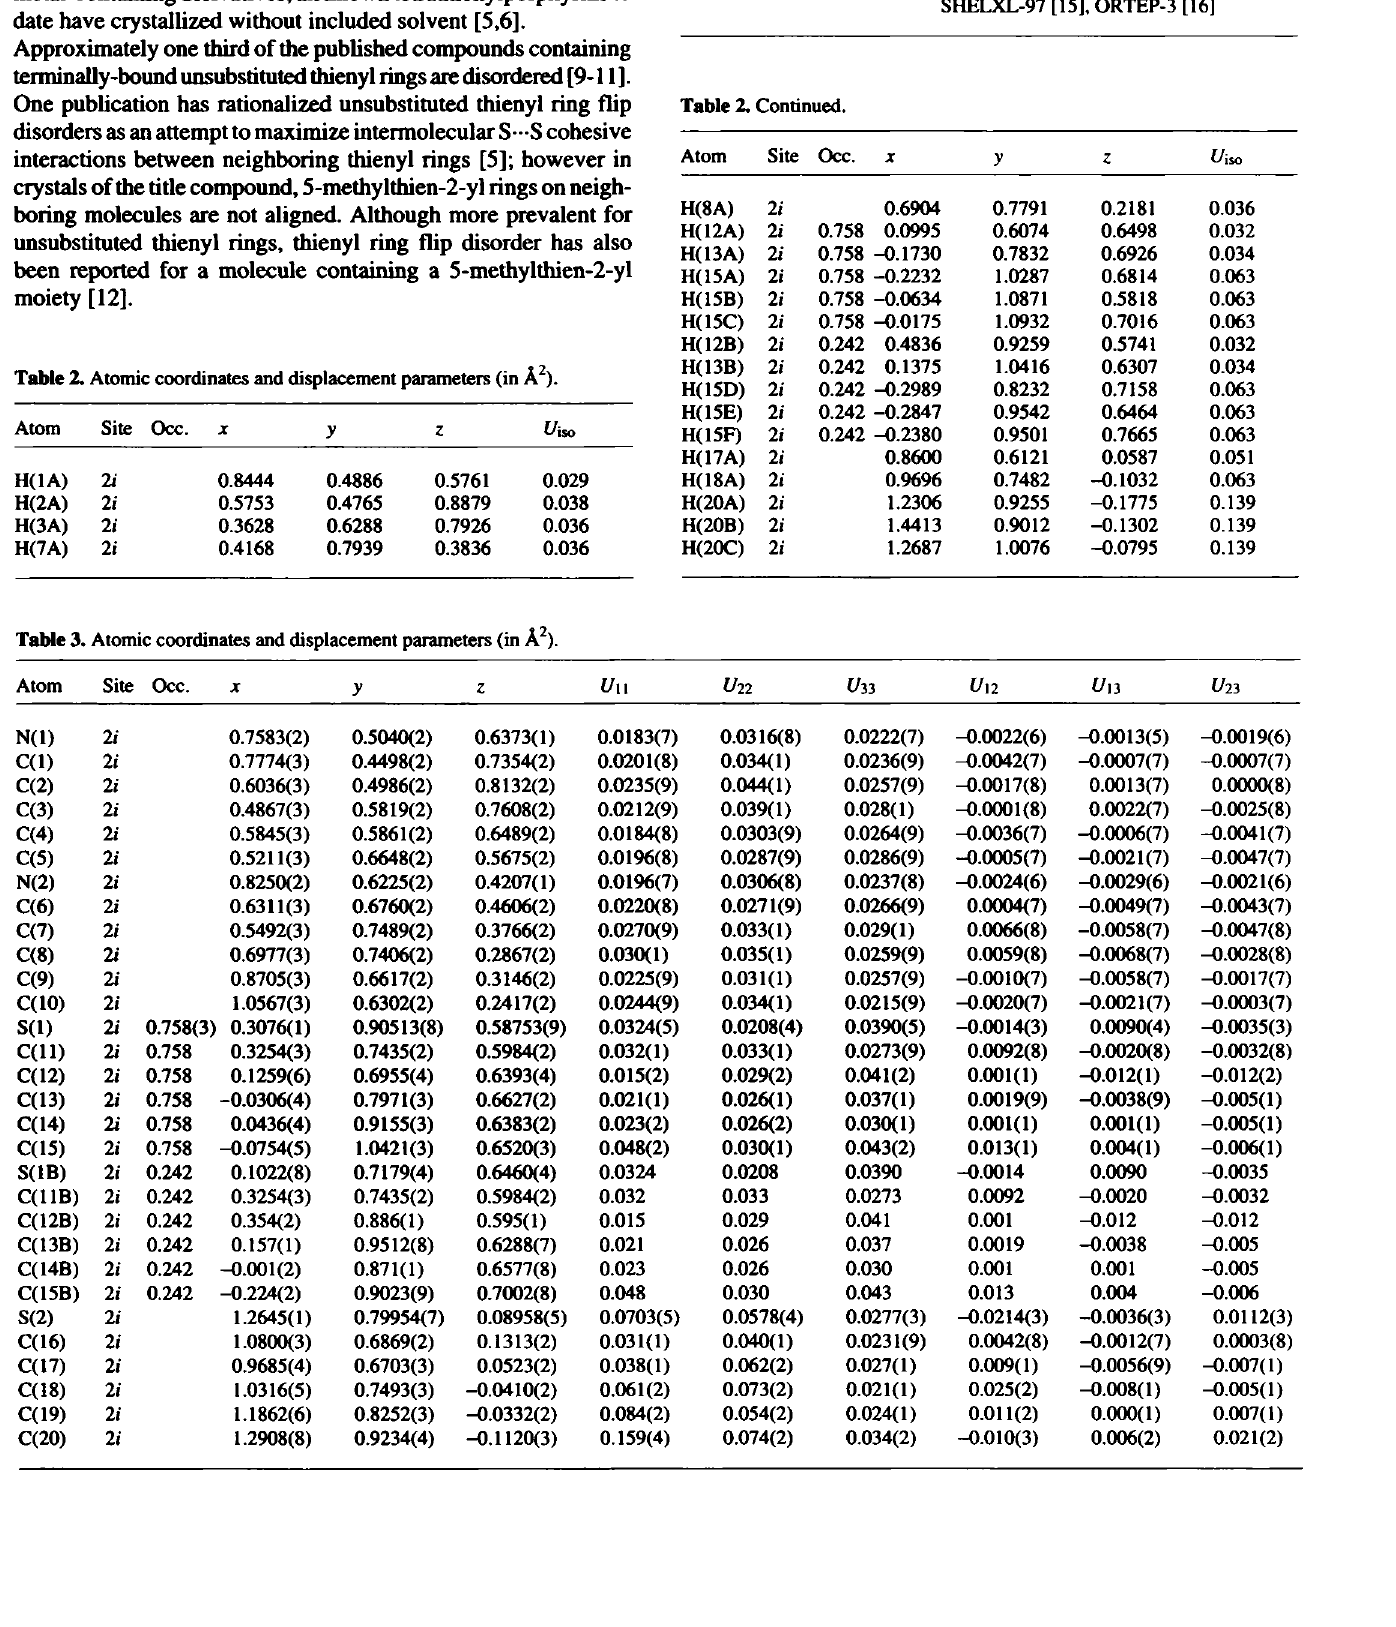
Table 2. Atomic coordinates and displacement parameters (in Â 2 ).